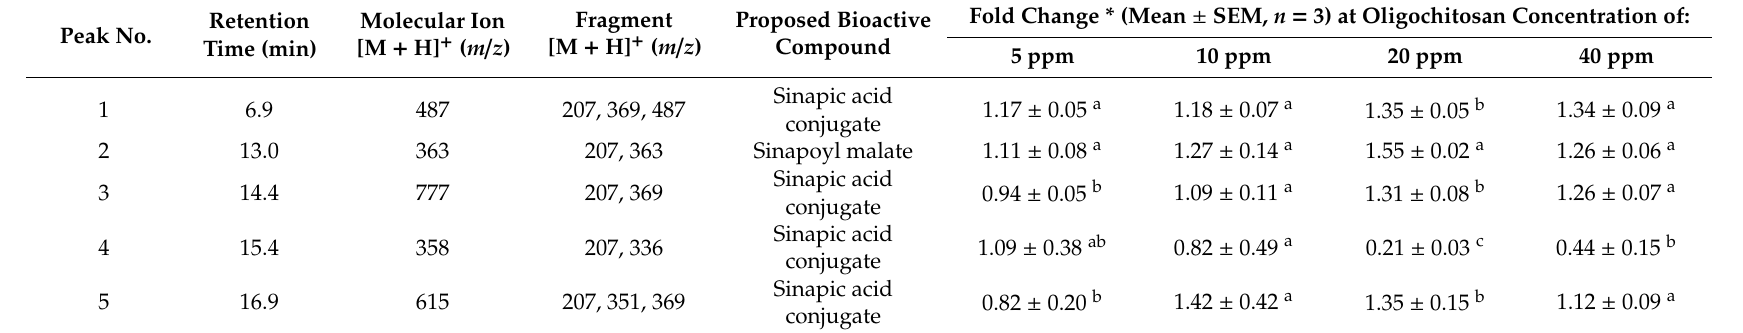
Table 2. Changes in sinapoyl derivative levels treated with various oligochitosan O-80 concentrations. Peak